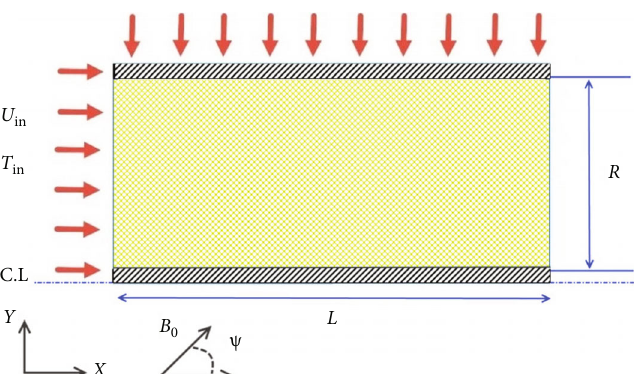
Figure 1: Schematic showing the problem that was